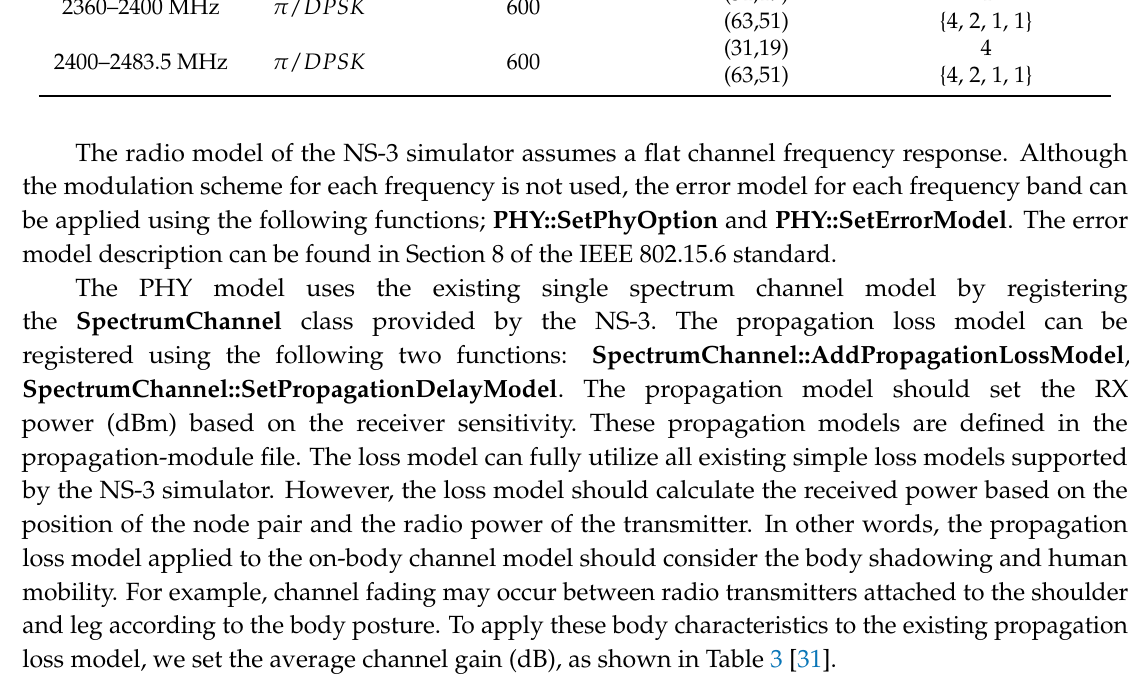
Table 3. Average gain for on-body channel